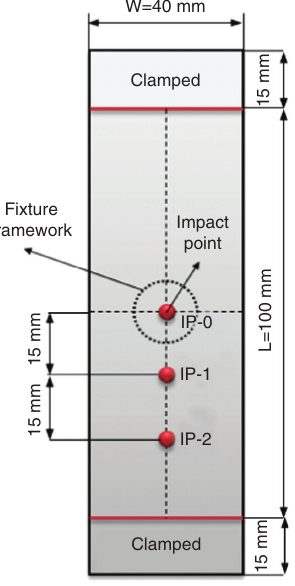
Figure 1 Geometric dimensions and impact points of the